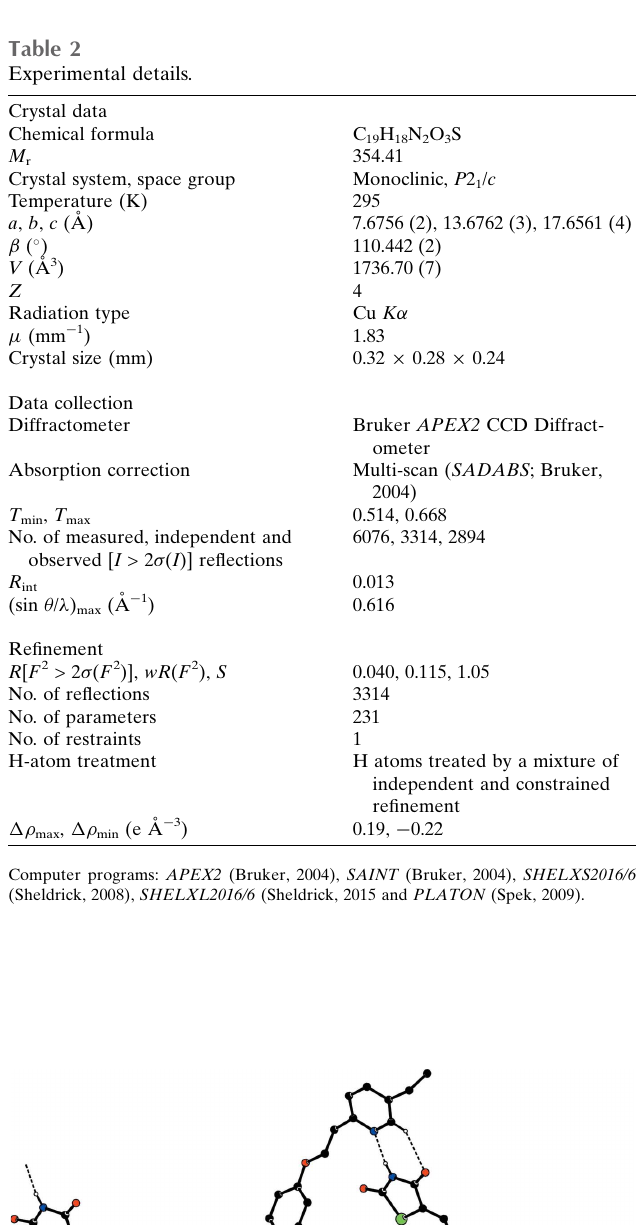
Figure 3 Partial packing of the crystal structure showing the R 2